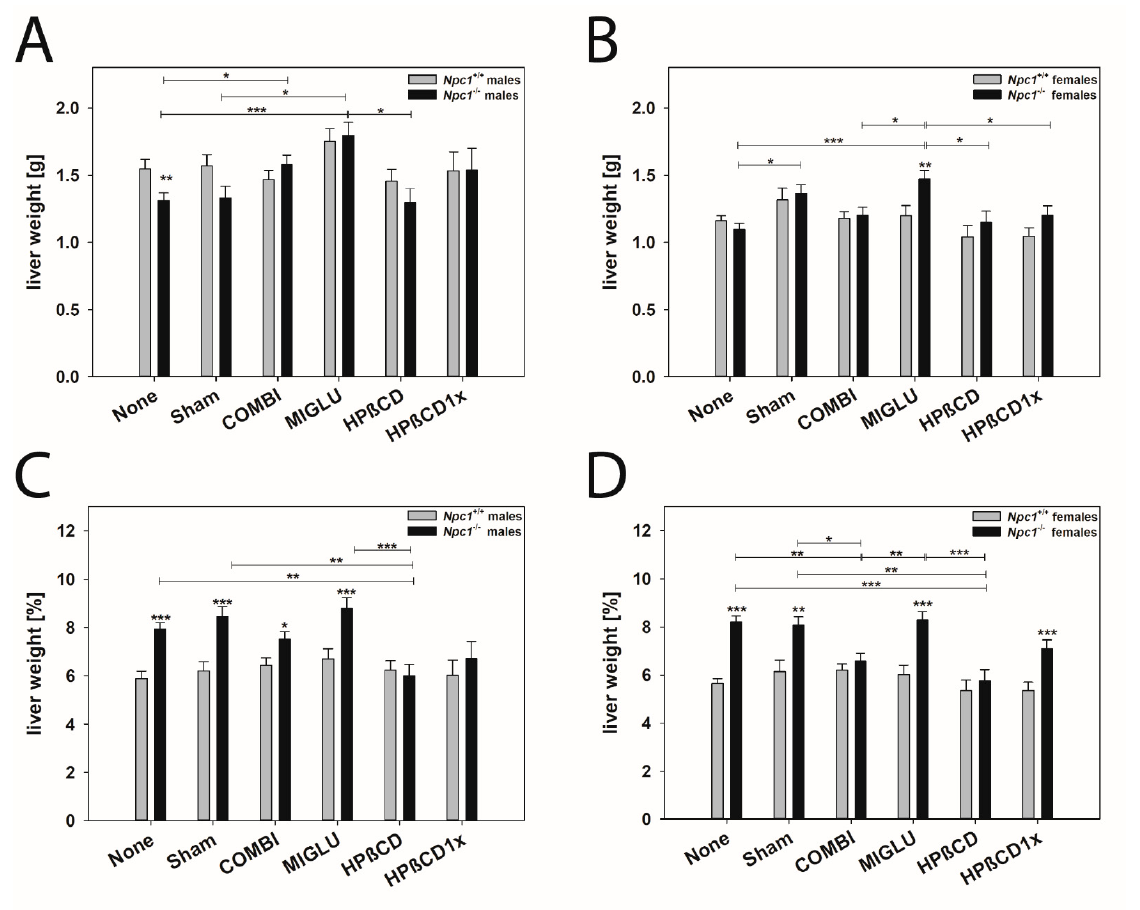
Figure 4. Liver weight ( A , B ) and relative liver weight ( C , D ) of Npc1 mice. Male ( A , C ) and female ( B , D ) mice. Significant post-hoc tests are indicated by asterisks (* p < 0.05, ** p < 0.01, *** p < 0.001). Data are means ± SEM.